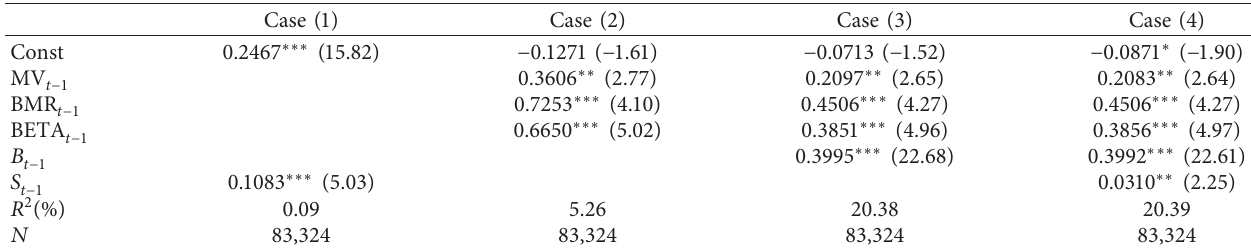
Table 7: Regression results of investor sentiment and order imbalance of big trade.